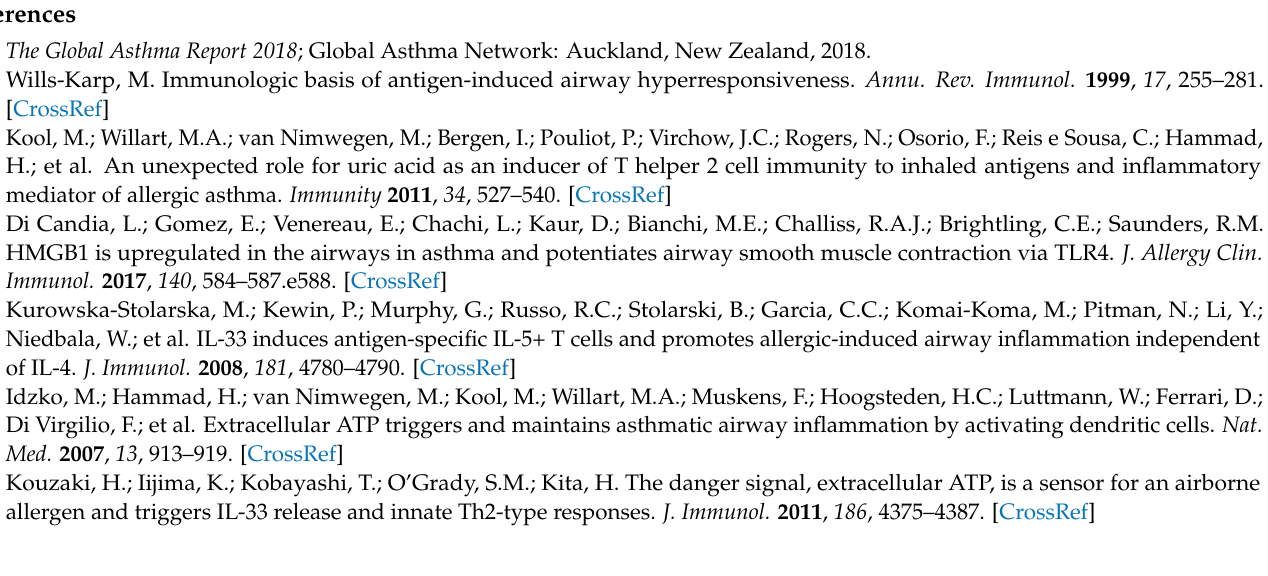
cytometry, Table S3: Information for MS analysis, Supplemental materials and methods: LC-MRM analysis of nucleotides, and Quantification of OVA-specific